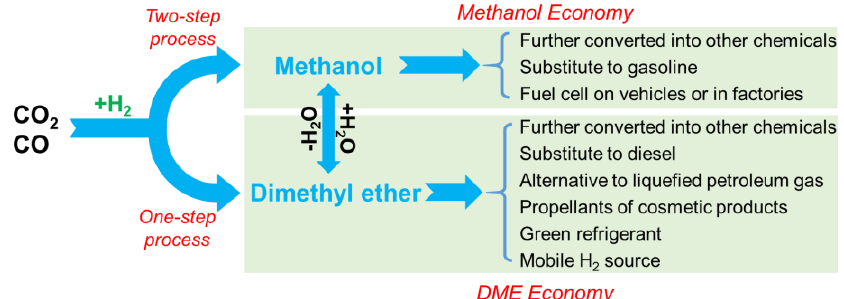
Figure 1. Scheme for the formation and utilization of methanol and dimethyl ether.